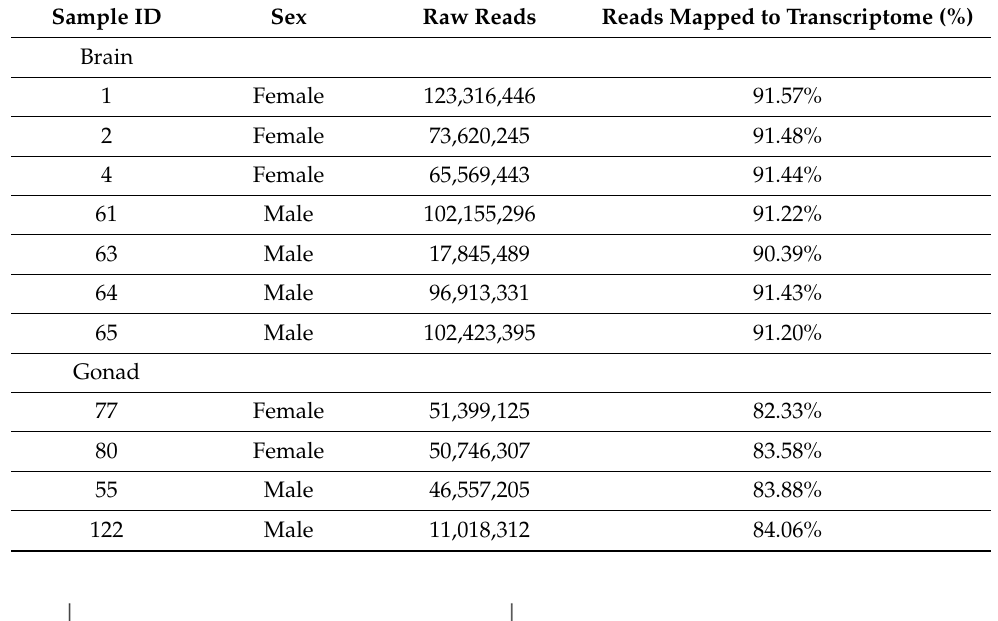
Table 1. Raw reads retrieved per sample and number of reads aligned to assembled transcriptomes for loggerhead brain and gonadal tissues.